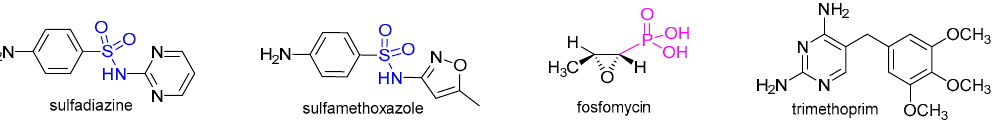
Figure 2. Structures of drugs approved for human use.